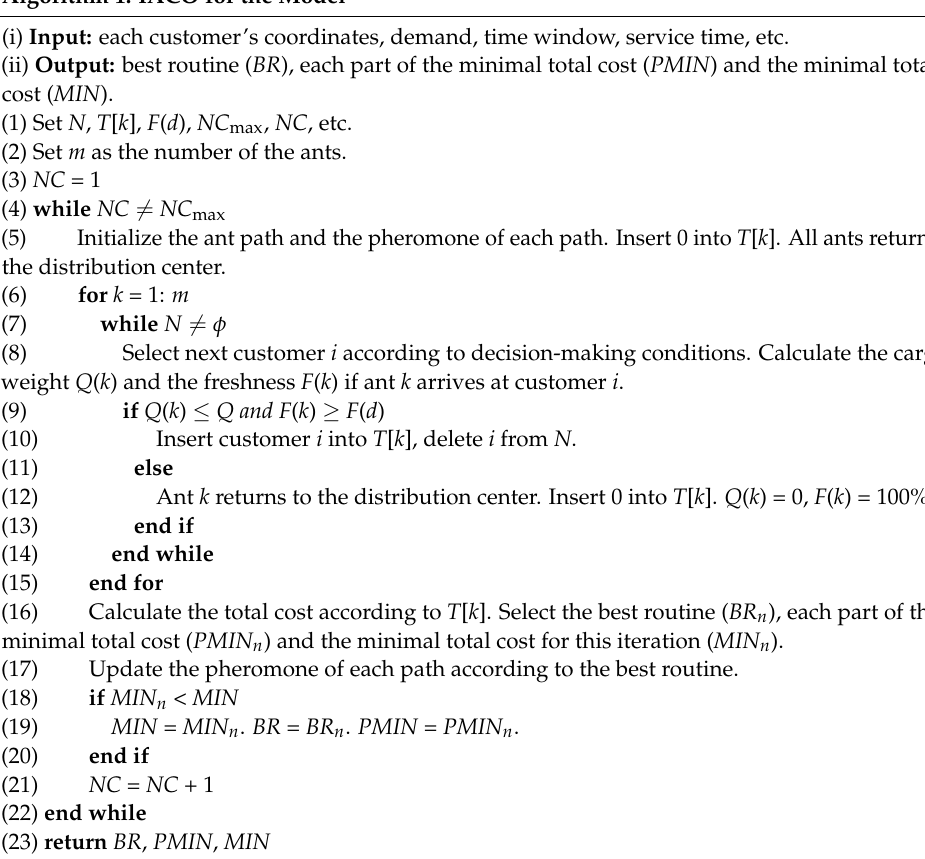
Algorithm 1. IACO for the